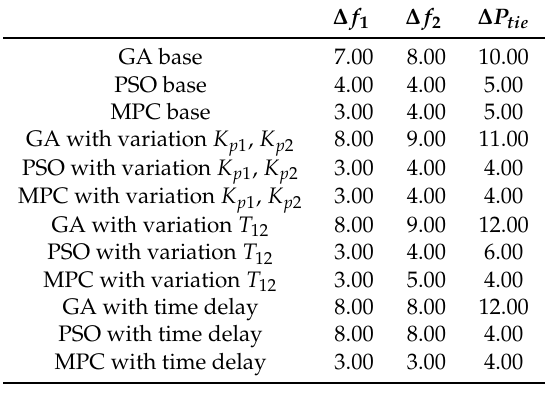
Table 5. Dynamic response comparison in terms of settling Time.